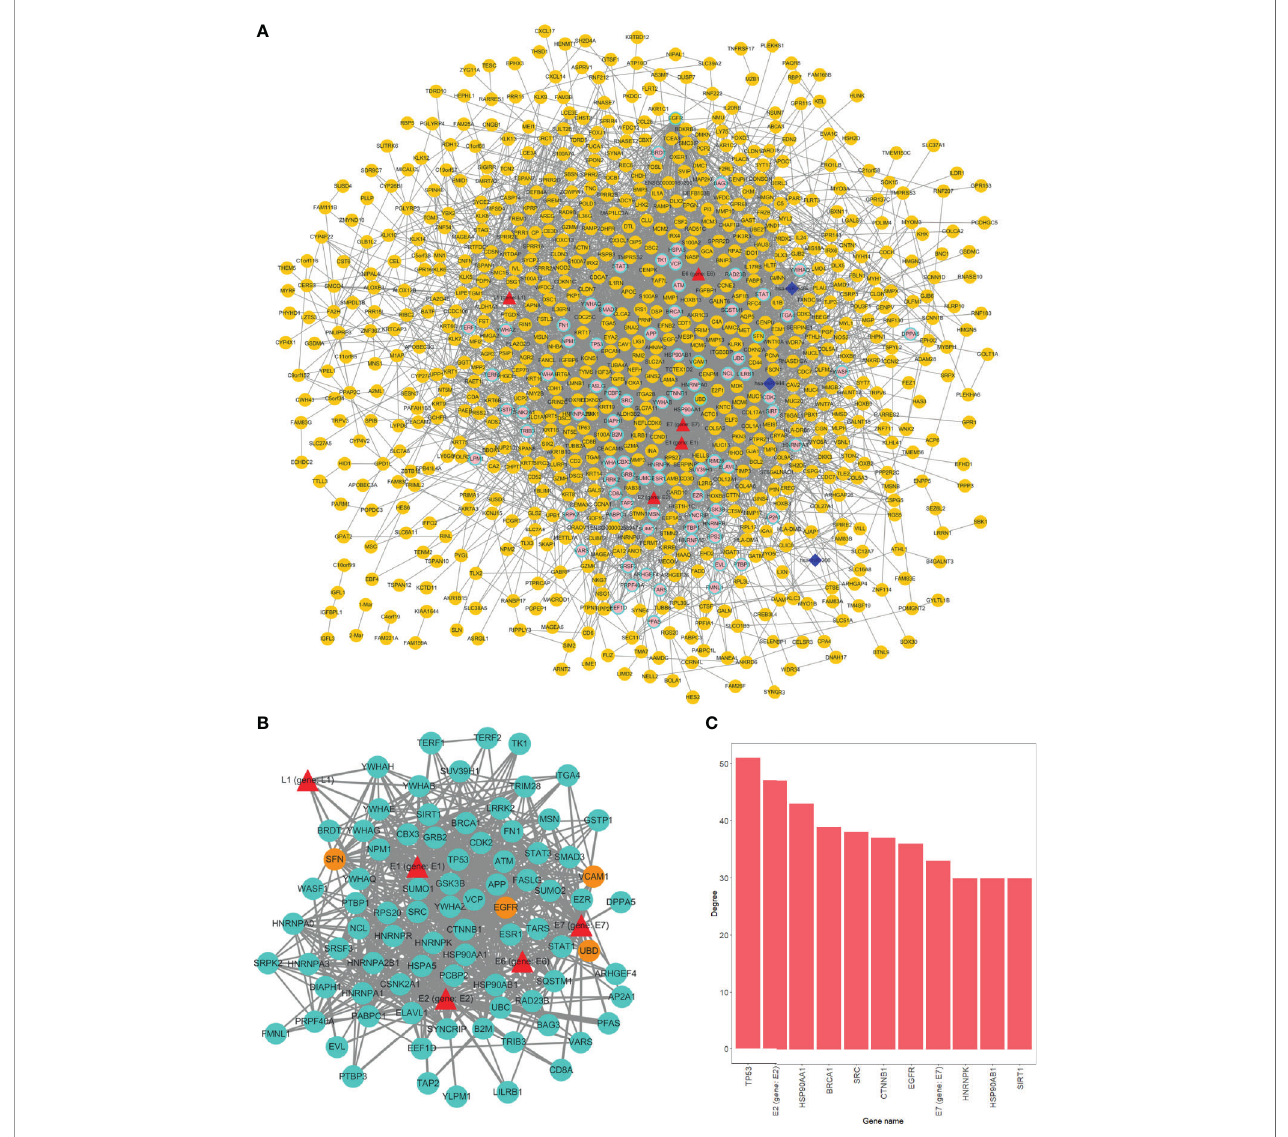
FIGURE 3 | Overview of interaction network. (A) Global network of miRNA-mRNA-protein interactions. HPV proteins are marked as red triangles; miRNAs are represented as deep blue diamonds; differentially expressed genes (DEGs) are orange circle; nondifferentially expressed genes are in pink. Circles with light blue border are HPV directly interacted human genes. (B) HPV proteins directly regulated subnetwork. Turquoise circles are HPV directly manipulated nondifferentially expressed genes; red triangles are HPV proteins; orange circles are HPV directly manipulated DEGs. (C) Top 11 genes degree distributions of HPV proteins directly regulated